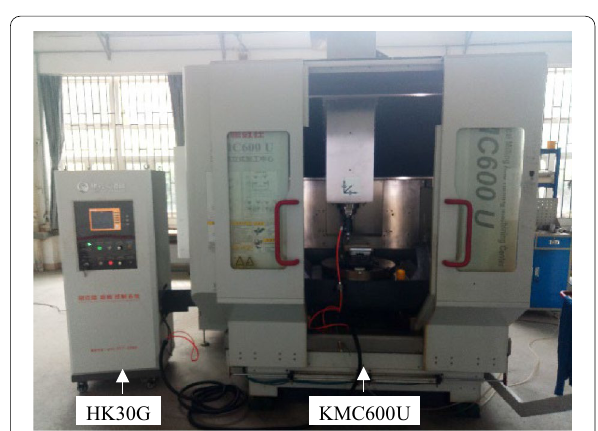
Figure 3 Processing equipment